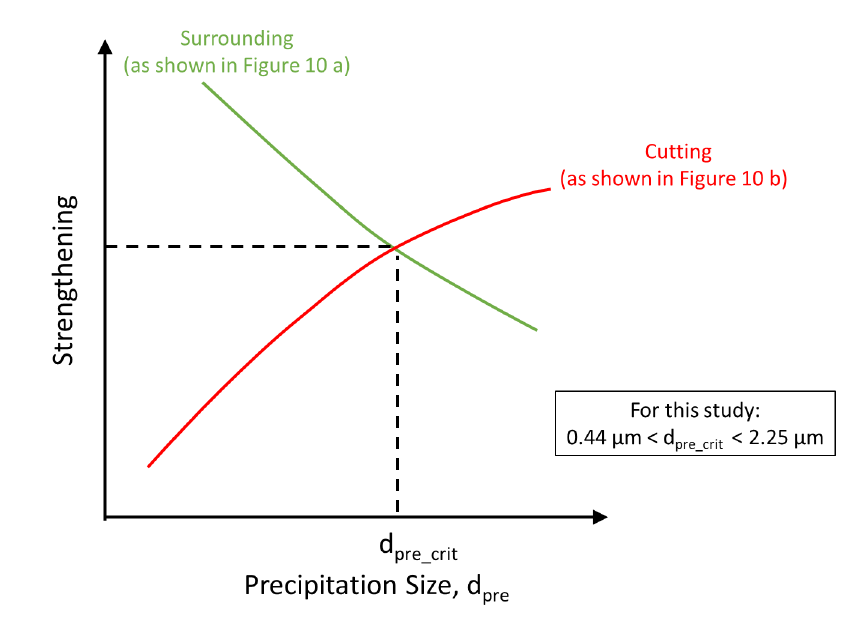
Figure 11. Schematic illustration of the influence of precipitate sizes on cutting or circulating a precipitation in the matrix material, reproduced and adjusted from [40].